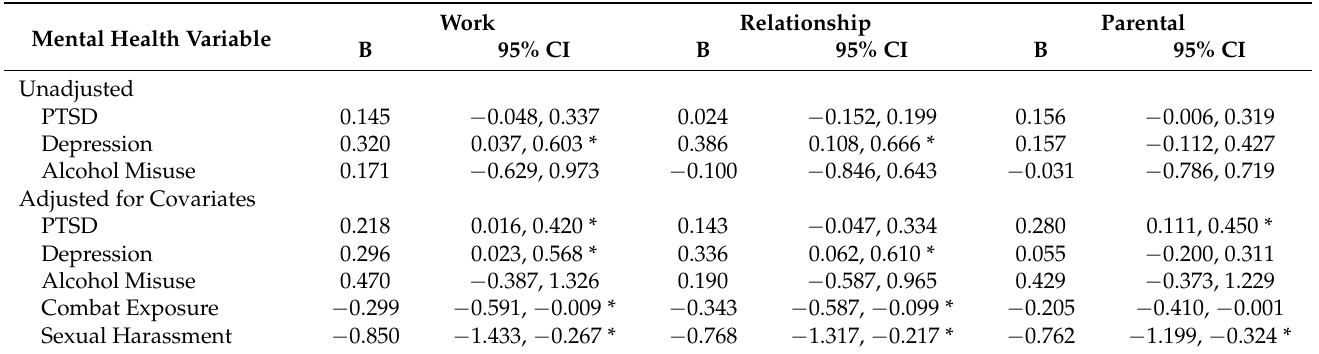
Table 2. Effects of T1 to T2 changes in mental health symptom severity on T2 to T3 psychosocial